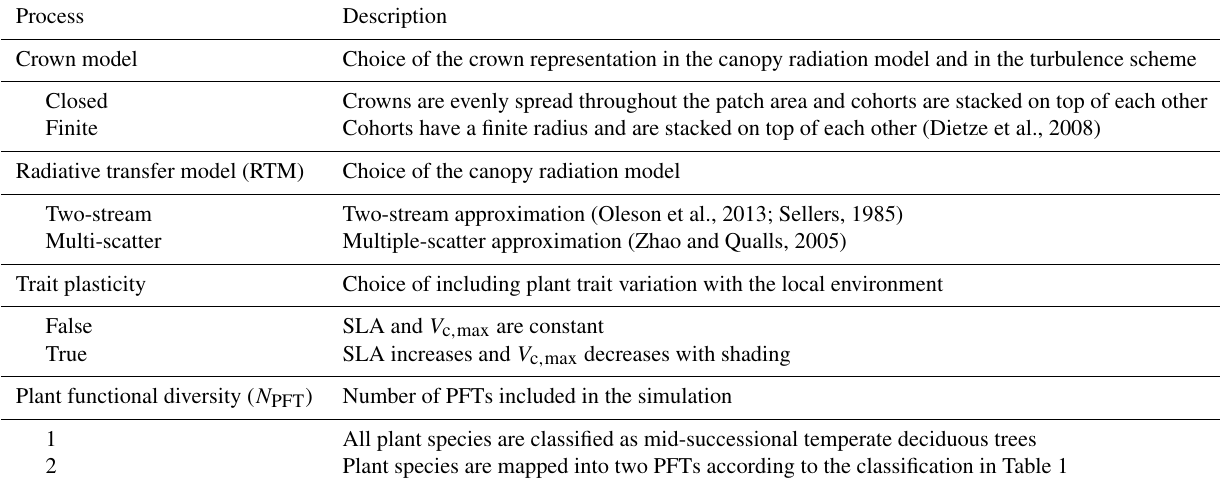
Table 2. List of varying processes included in the model ensembles in order to evaluate the model structural uncertainty, as well as their possible configurations. Adapted from Shiklomanov et al. (2020).